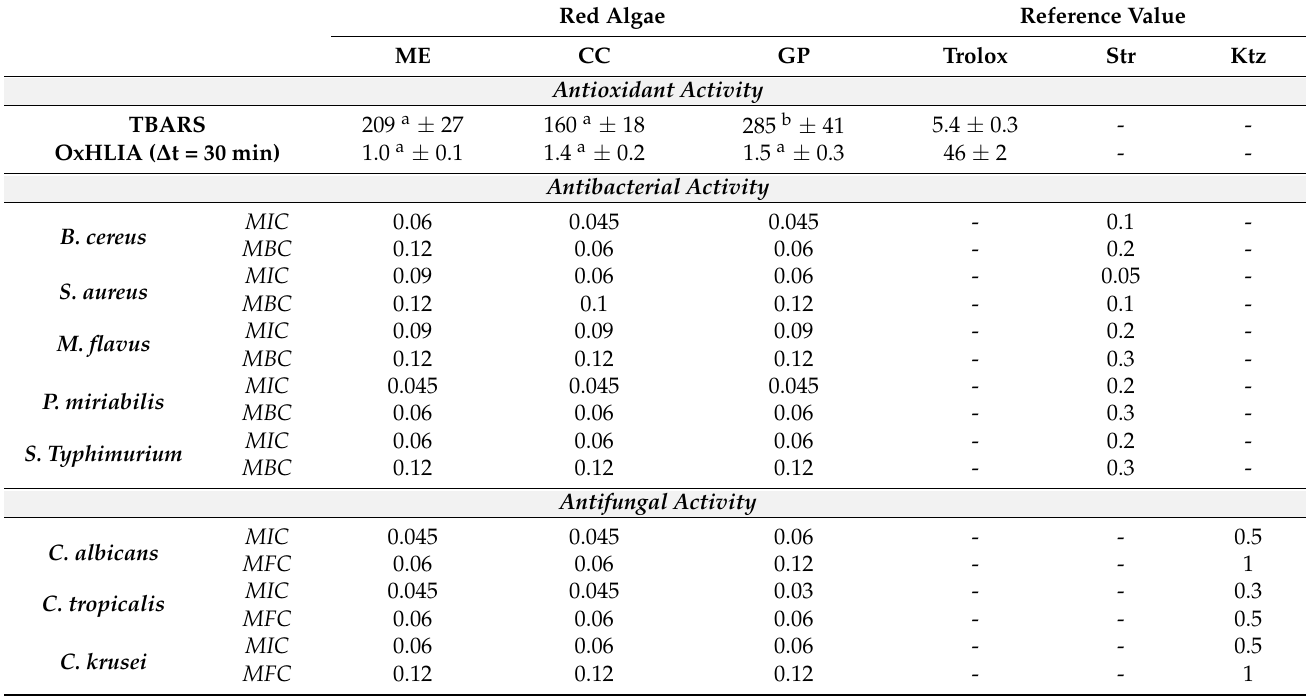
Table 8. Antioxidant ( EC 50 ; µ g/mL; mean ± standard deviation (SD)) ( x ± σ ) and antimicrobial activity (mg/mL) of the extracts obtained from the studied marine